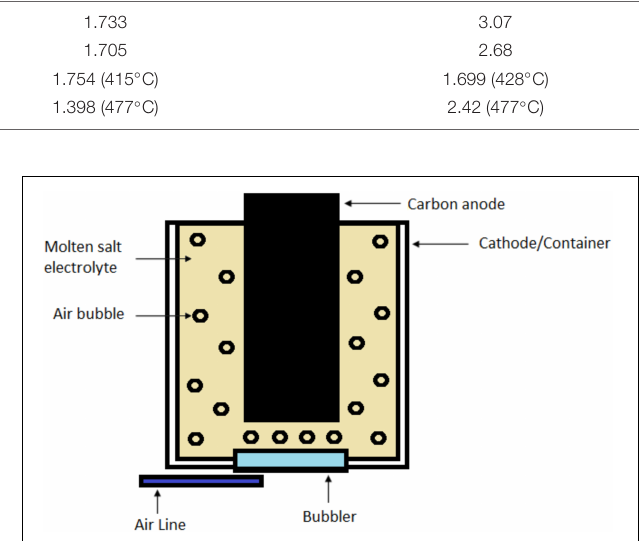
TABLE 1 | Data on some molten alkali hydroxides (Janz et al., 1968; Dauby et al., 1979; Claes and Gilbert, 1985). Species